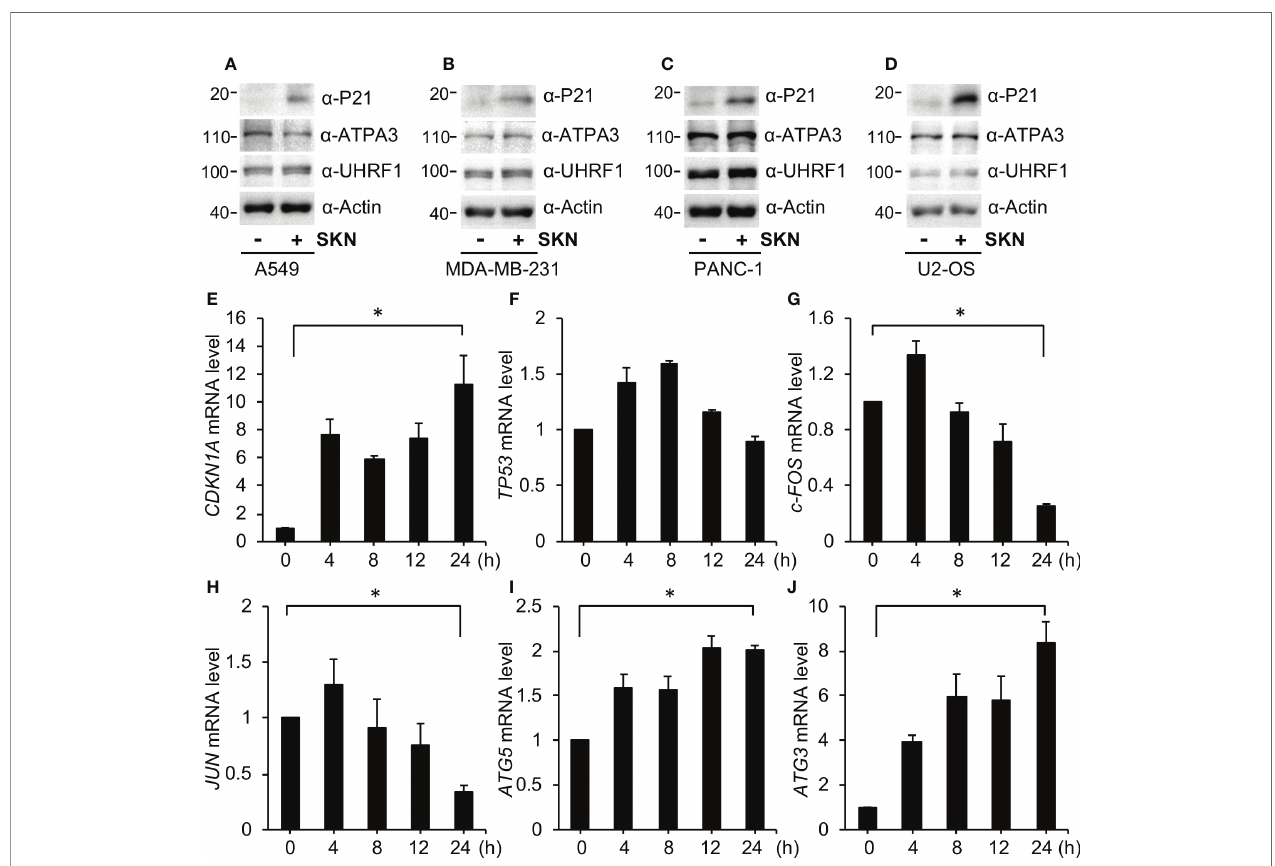
FIGURE 7 | Shikonin upregulates P21 and alters gene transcription. (A) A549, (B) MDA-MB-231, (C) PANC-1 and (D) U2OS cells were treated with 5 m M of Shikonin for 6 h, and protein expression was measured by speci fi c antibodies. For qPCR analysis, A549 cells were treated with 5 m M Shikonin for 0, 4, 8, 12 and 24 h, RNA was isolated, and expression of genes including CDKN1A (E) , TP53 (F) , c-FOS (G) , JUN (H) , ATG5 (I) , and ATG3 (J) was analyzed. Data represent mean and standard deviation from fi ve replicates. *P < 0.001 between 0 and 24 h